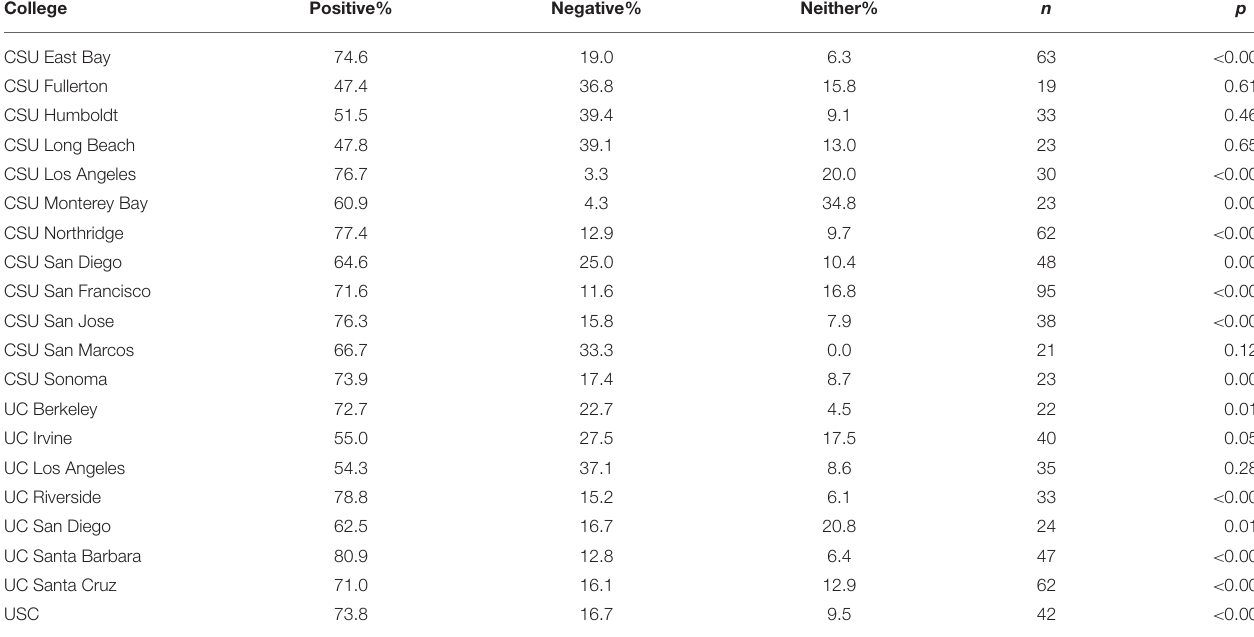
TABLE 2 | Proportional comparisons of sentiment by 4-year college, for top 20 campuses, with p -value denoting test of positive vs. negative classifications. College